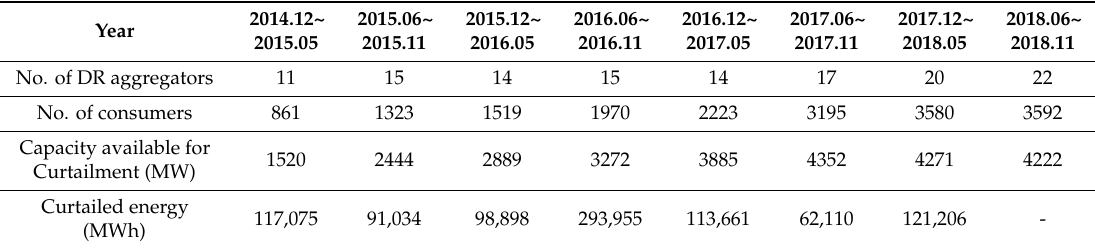
Table 2. Consumers and curtailed power after market opening (provided by KPX, July 2018).